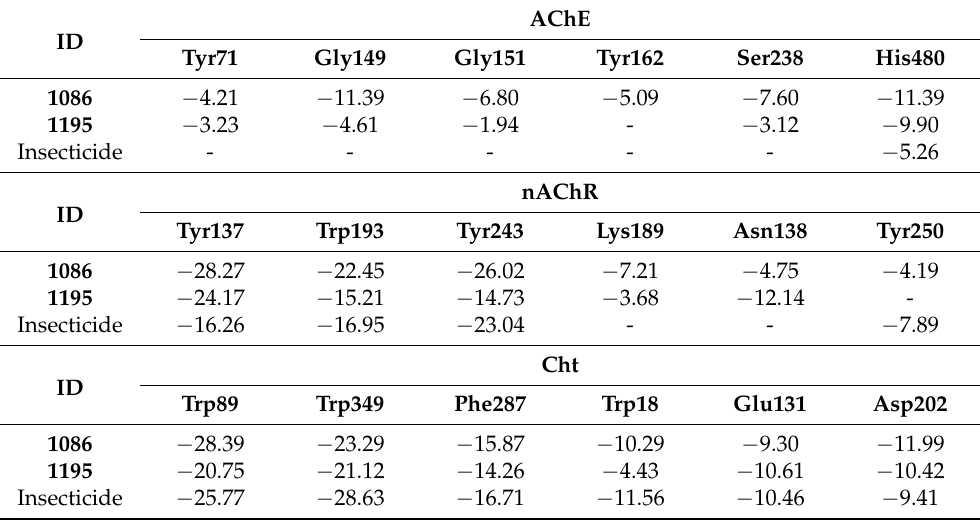
Table 11. Summaries of the interaction values of the main amino acids for D. melanogaster